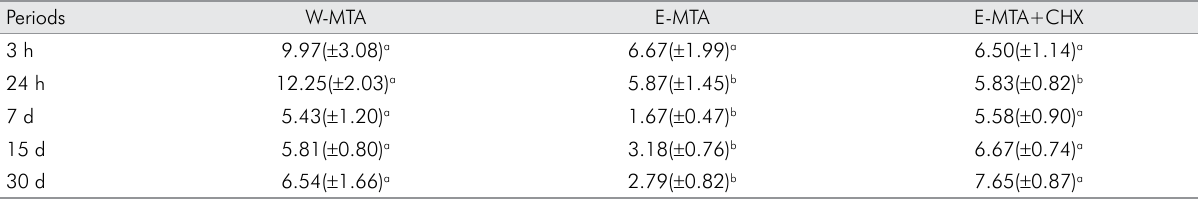
Table 3. Calcium released (mean ± standard deviation, expressed as ppm, n = 5 for each material) in soaking water after immer- sion of the samples in different evaluation periods (3 h to 30 days).